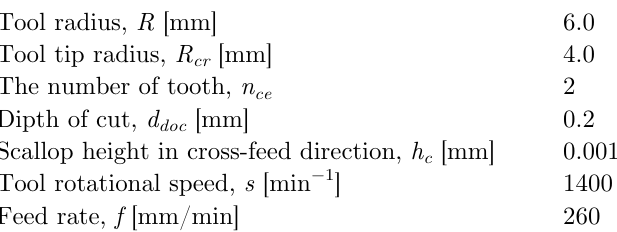
legends represented increasing tendency with increasing u